Question: Condense the content of this figure into a single sentence.
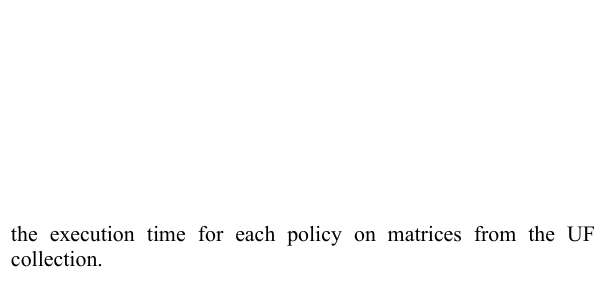
Answer: shows that almost all executions closed by using the time  policy. But the cases of epb1 and epb2 indicate the effectiveness  of the time policy. In the case of epb1, the execution with the time  policy was 10× faster than that with the memory policy. This is  because a large restarting frequency is required to establish fast  convergence in epb1, but it requires much memory. This is totally  against the memory policy. For this reason, the execution time  with the memory policy was dramatically increased.